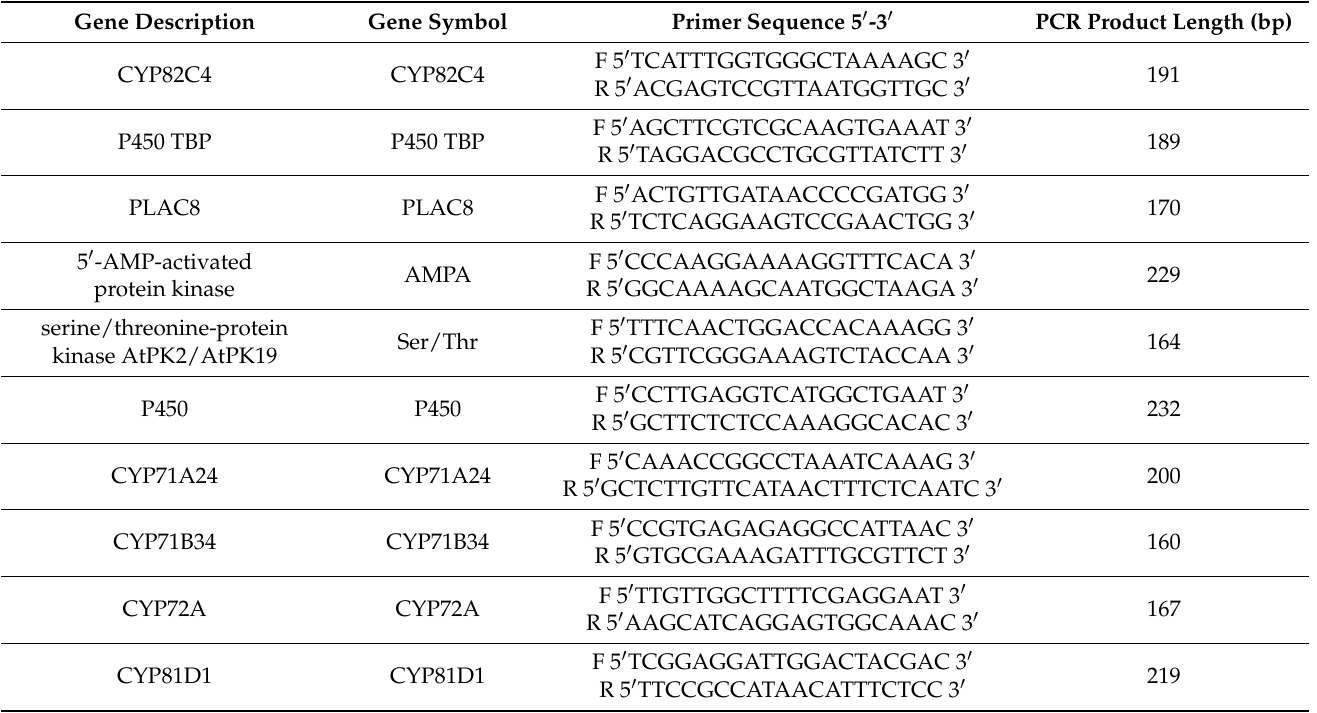
Table 3. Sequences of synthesized primers for